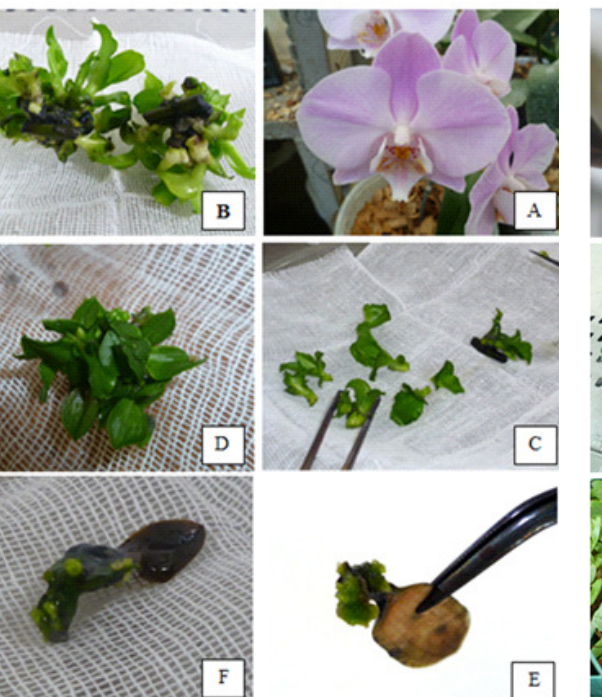
Fig. 2. The main stages of producing plantlets from leaves that had grown in vitro from the initial tissue culture of nodes of flower stalks. A: the Phalaenopsis orchid var. ‘Manila’. B: shoots that grew by tissue culturing the nodes of flower stalks on MS medium containing 4.4 mg l -1 BA and 1 mg l -1 NAA. C: separating the leaves from the shoots resulted from tissue culturing the nodes of flower stalks. D: protocorms that grew on the edges of leaves in MS medium containing 4 mg l -1 TDZ. E: demonstrating the capability of the base of leaves in producing protocorms. F: protocorms that are produced in culture medium with 1 mg l -1 TDZ